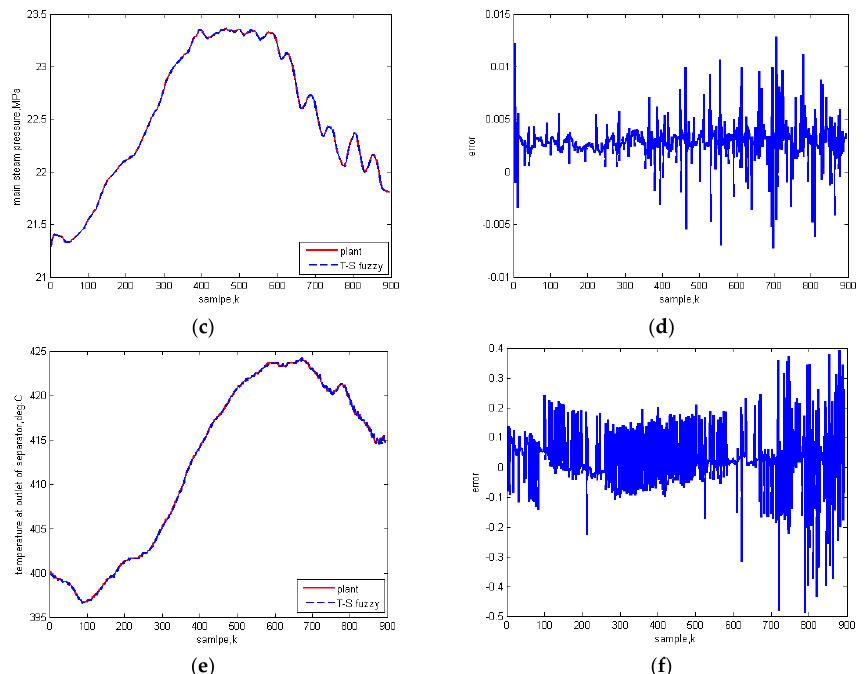
Figure 5. ( a ) Comparison of the T ‐ S fuzzy model and test data for electrical power output; ( b ) validation error of the load model; ( c ) comparison of the T ‐ S fuzzy model and test data for main ‐ steam pressure; ( d ) validation error of main ‐ steam pressure model; ( e ) comparison of the T ‐ S fuzzy model and the test data for the separator outlet steam temperature; and ( f ) validation error of the separator outlet steam temperature model.